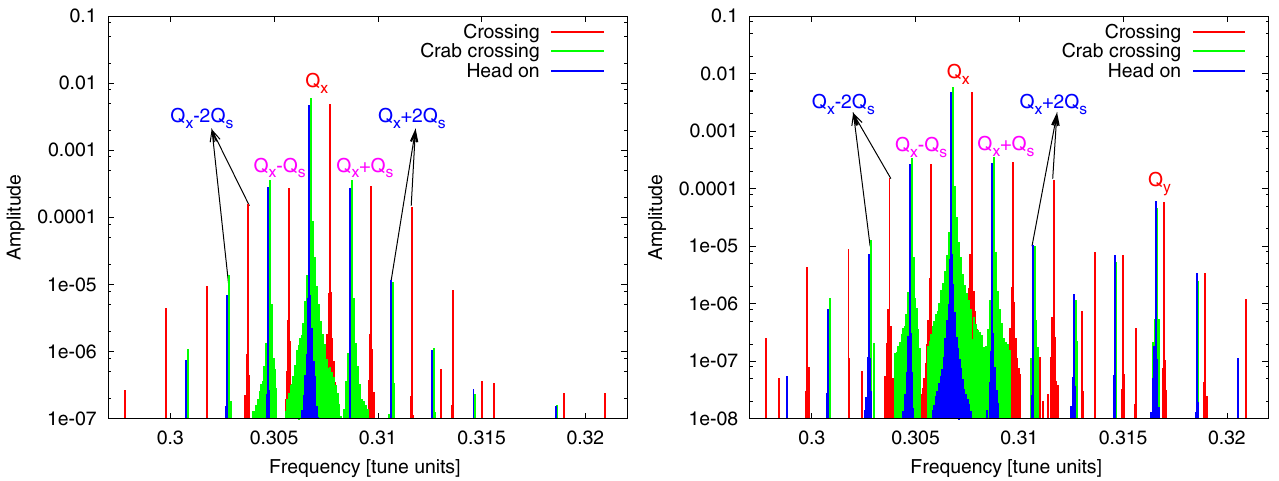
FIG. 29. (Color) Frequency spectrum computed from the turn-by-turn horizontal beam position, without (left) and with (right) nonlinear magnet errors, for a particle launched with 1 (cid:3) offset in x , y , and z . The second sideband synchrobetatron resonances introduced by the crossing collision are suppressed by the crab cavities (synchrotron tune Q s ¼ 0 : 001 97 , and chromaticity Q 0 x;y ¼ 2 ). The spectrum with crossing angle and crab cavities resembles the head-on collision case.